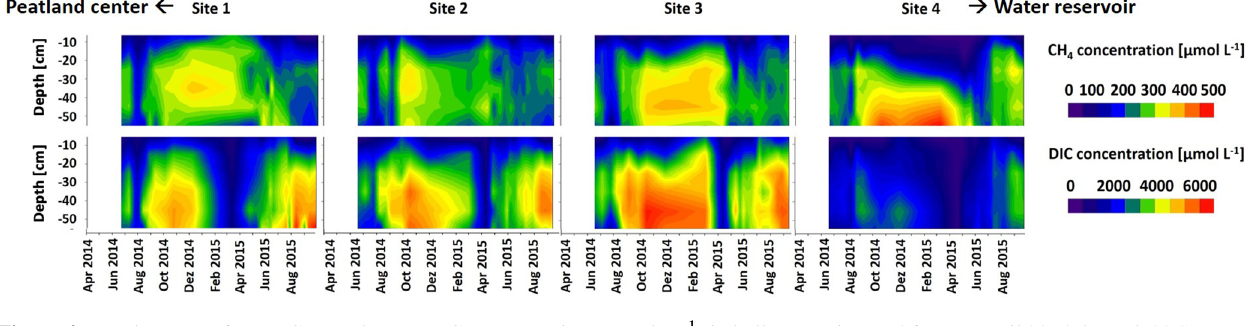
Figure 4. Development of mean CH 4 and mean DIC concentrations (µmolL − 1 ) in hollows at sites 1–4 from 1 April 2014 through 22 Septem- ber 2015. Concentrations were interpolated based on biweekly sampling at depths of 5, 15, 25, 35, 45, and